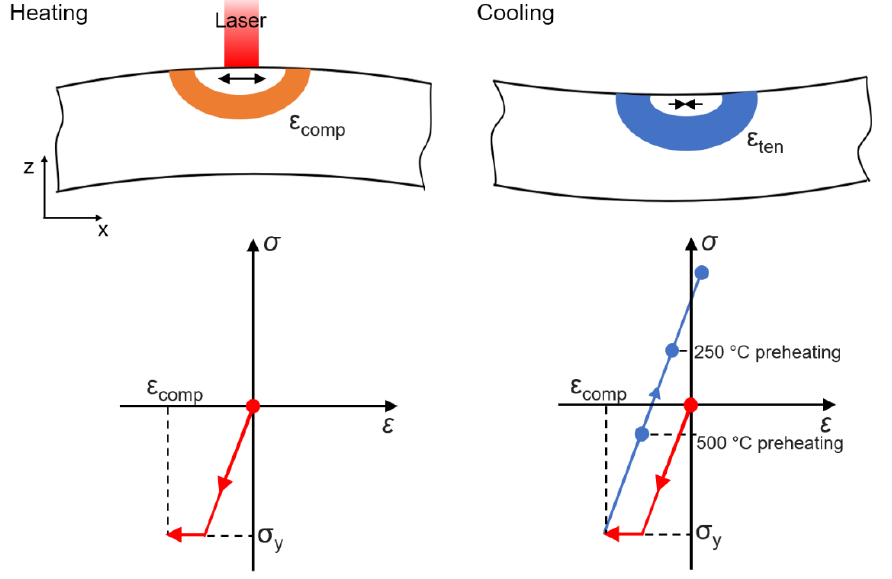
Figure 13. Schematic illustration of temperature gradient mechanism (TGM) model, according to [6].